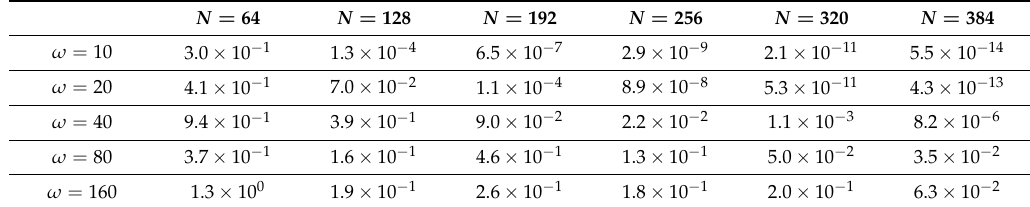
Table 10. Absolute errors of 2D-d for Example 4.